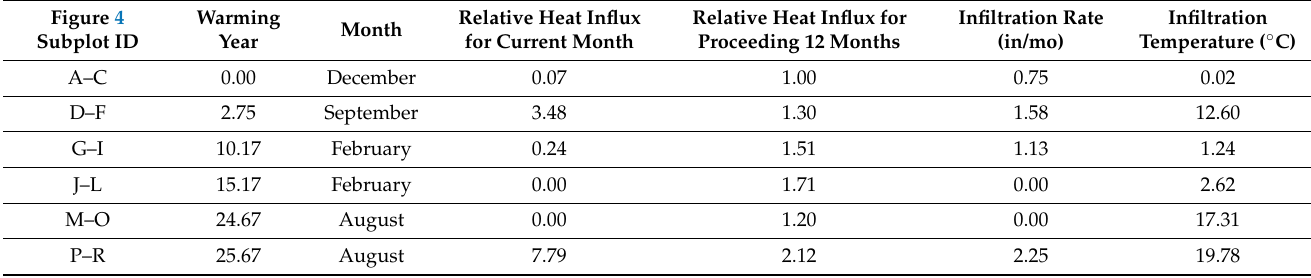
Table 3. Additional information pertaining to subplots shown in Figure 4. Figure 4 Subplot